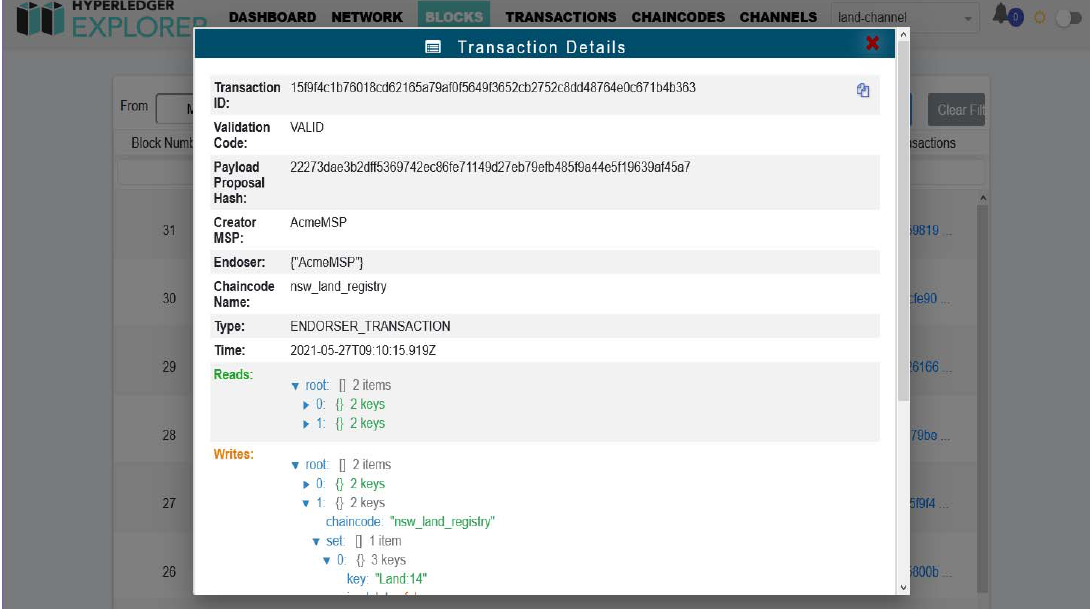
Figure 8. Viewing transaction details in a block through the Hyperledger Explorer tool.